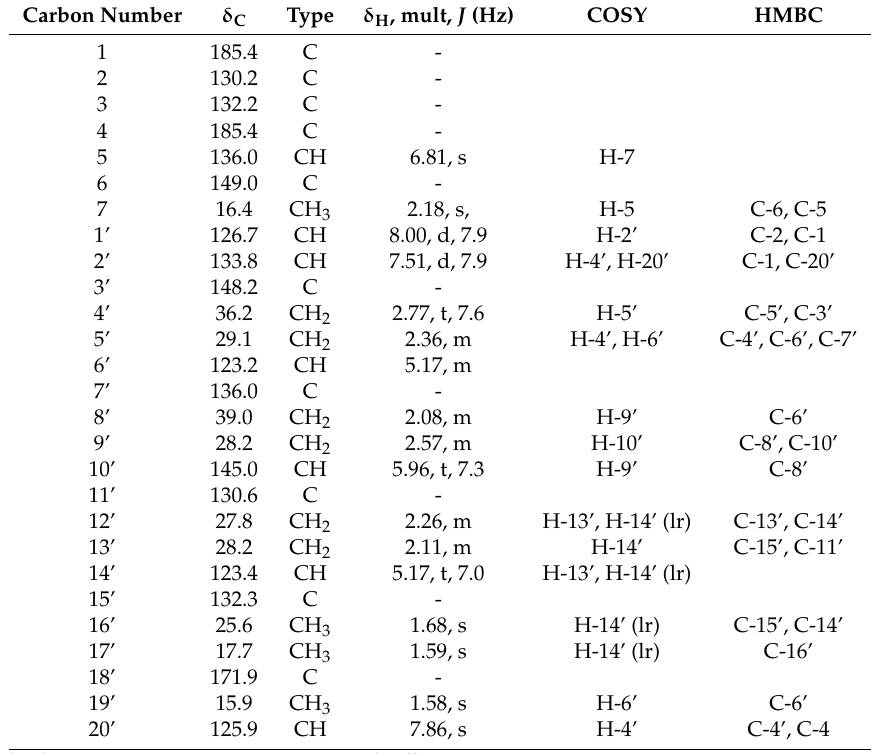
Table 1. NMR spectroscopic data for sarganaphthoquinoic aicd ( 10 ) (600 and 125 MHz, CDCl 3 ). Carbon Number δ C